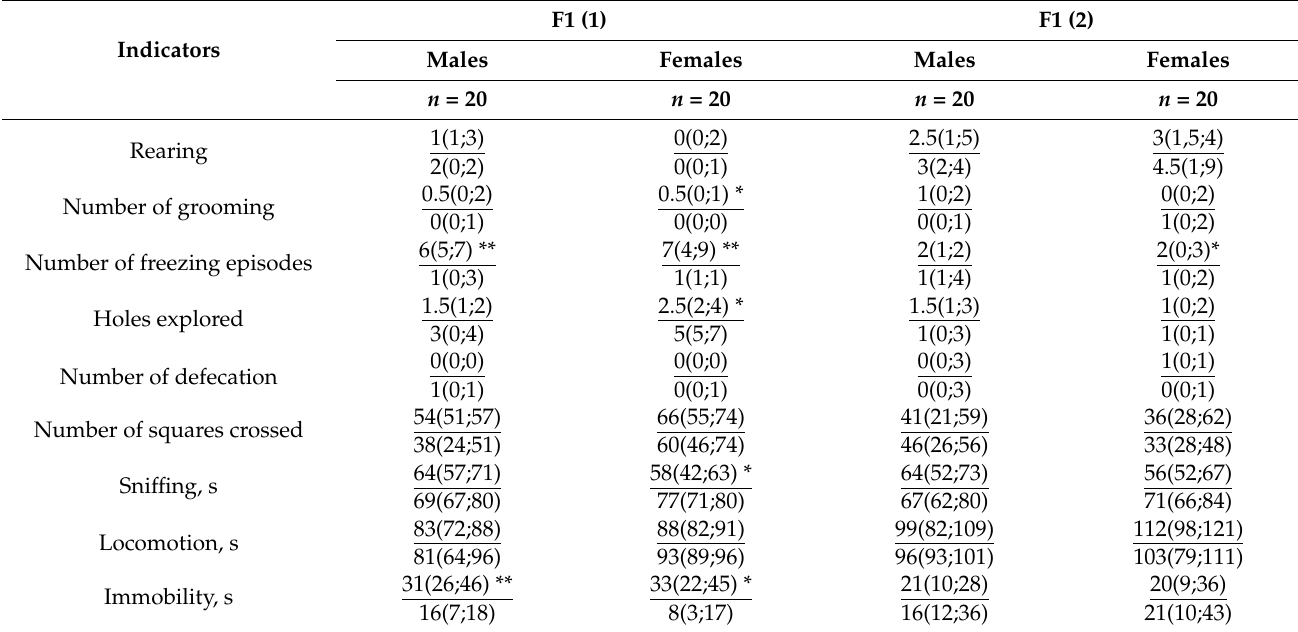
Table 2. Open field behavior in offspring of rats exposed to biomass smoke, Me